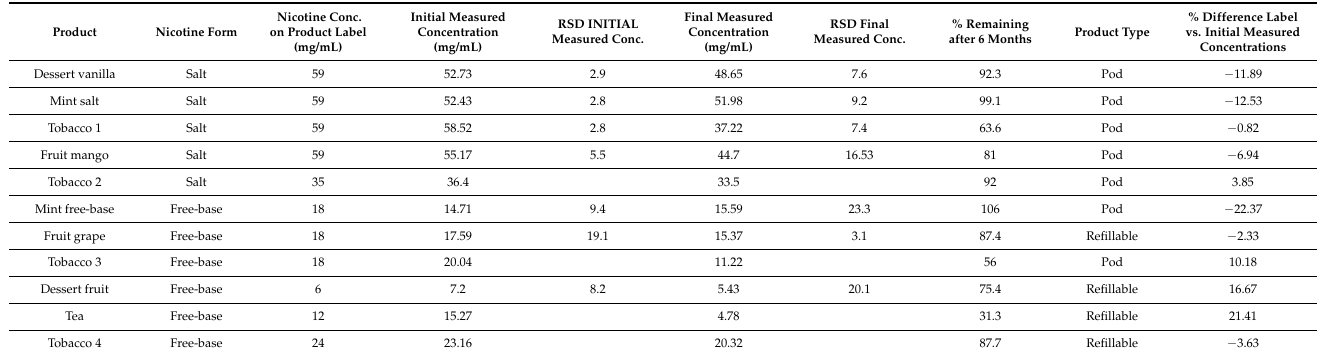
Table 5. Concentrations of nicotine and characteristics of products used in stability trials.